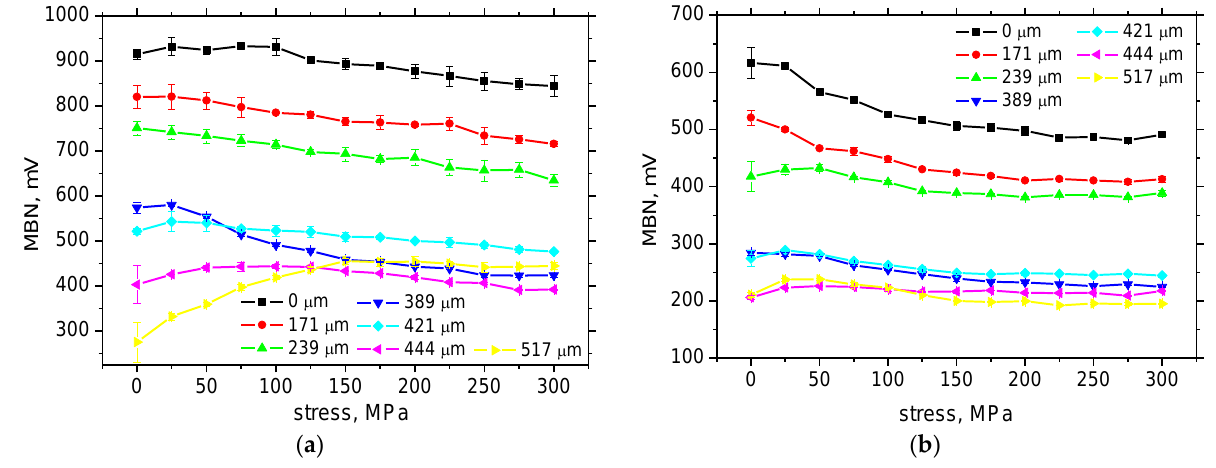
Figure 11. MBN versus tensile stress for the different coating thickness. ( a ) RD and ( b ) TD. Evolution of MBN versus TS (Figure 11b) exhibited a mainly descending tendency for the uncoated sample, and the samples of lower coating thickness, followed by a saturation phase for higher TS as a result of the preferential orientation of DWs in the RD. The relationship becomes flatter along with increasing coating thickness. Figure 11 also demonstrates that the differences between the samples with a coating of thickness above 239 µ m were low, especially for the higher TS and TD. The evolution of PP versus TS (see Figure 12a) corresponded with the relationship of MBN versus TS where the decreasing MBN was closely connected with the increasing magnetic hardness of the body, and vice versa [10,28]. For this reason, the progressive decrease of MBN for the uncoated sample (and samples of lower coating thickness) occurred together with increasing PP in RD. As soon as MBN versus TS saturates for the samples of the thicker coating, PP also tended to saturate versus TS. PP versus TS in the TD exhibited poor sensitivity, and hence PP in TD could not be employed for assessment of TS (see Figure 12b).